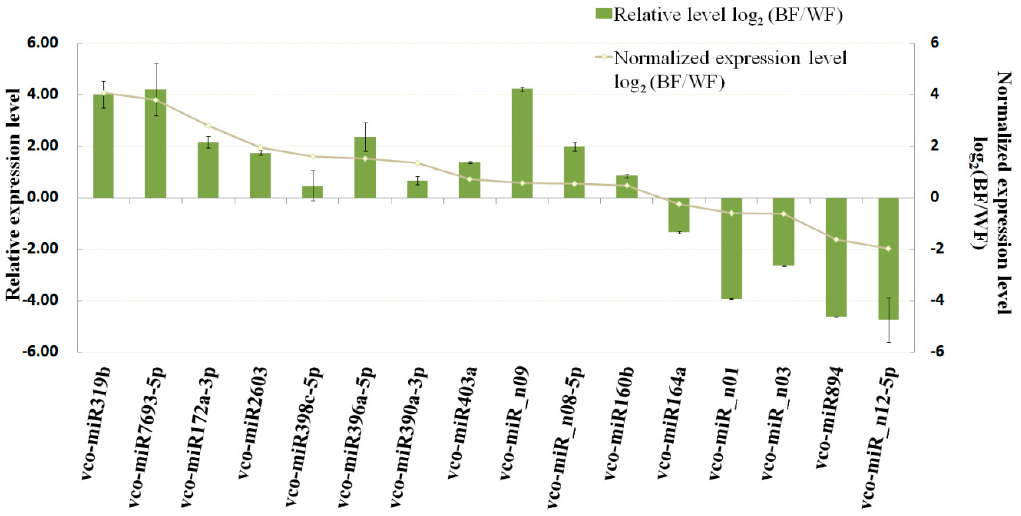
Figure 4. Expression comparison of selected miRNAs between WF and BF stages in blueberry by qRT- PCR and deep sequencing. Gray line represents transcript abundance changes calculated. Green bar indicates relative expression level determined by qRT-PCR analysis. The standard error of the mean is represented by an error bar. WF and BF refer to white fruit and blue fruit, respectively.